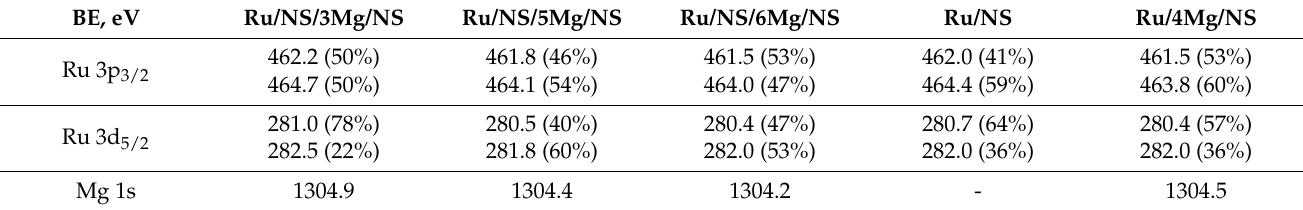
Table 3. XPS BE values of the catalysts in the Ru 3p 3/2 , Ru 3d 5/2 and Mg 1s